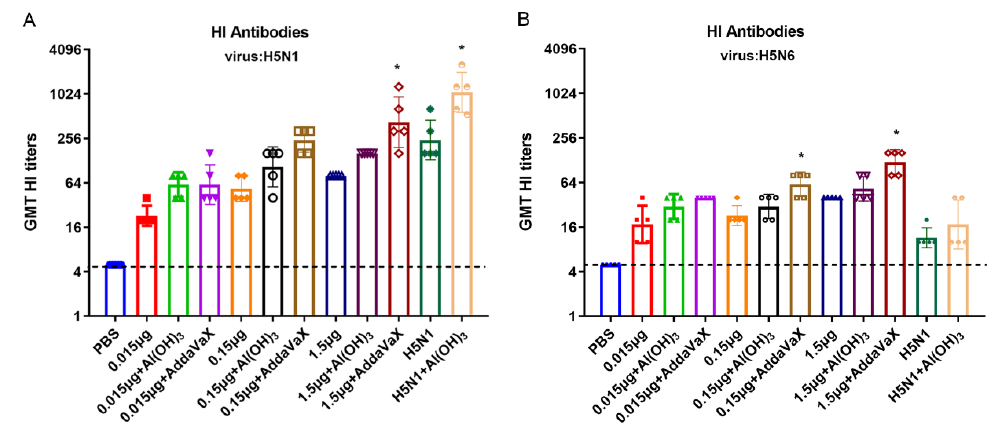
Figure 5. Cross-reactive neutralizing antibody against different clades of H5 viruses. Cross-reactive neutralizing antibody responses were determined by HI assay. ( A ) Antisera were analyzed for HI titers against H5N1 virus. ( B ) Antisera were analyzed for HI titers against H5N6 virus. Comparing the vaccination effect among various formulations, an asterisk * indicates a significant difference ( p < 0.05) detected by one-way ANOVA.